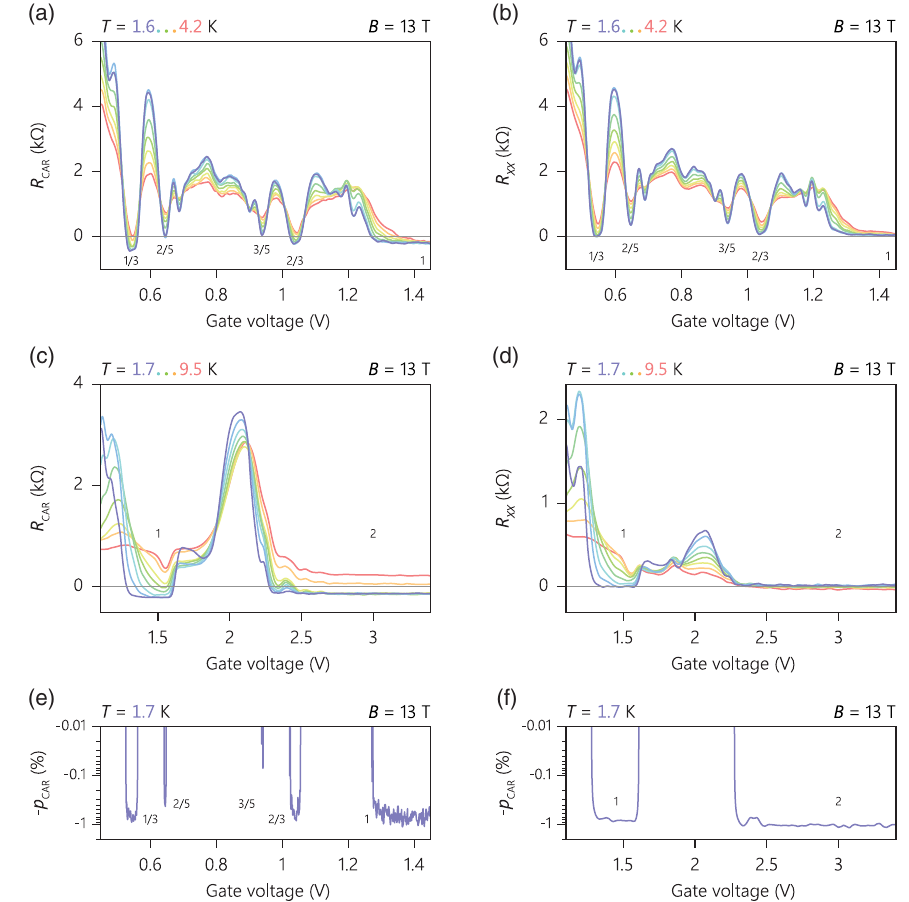
FIG. 8. Crossed Andreev reflection in the FQH state in device 2. (a),(b) R and R as a function of gate voltage at B ¼ 13 T for XX CAR < 0 at the highlighted fillings indicates crossed Andreev reflection. (c),(d) Same as (a) and (b) but for different temperatures T . R CAR integer fillings 1 and 2 in a larger T range. (e),(f) p at T ¼ 1 . 7 K, respectively, from (a) and CAR